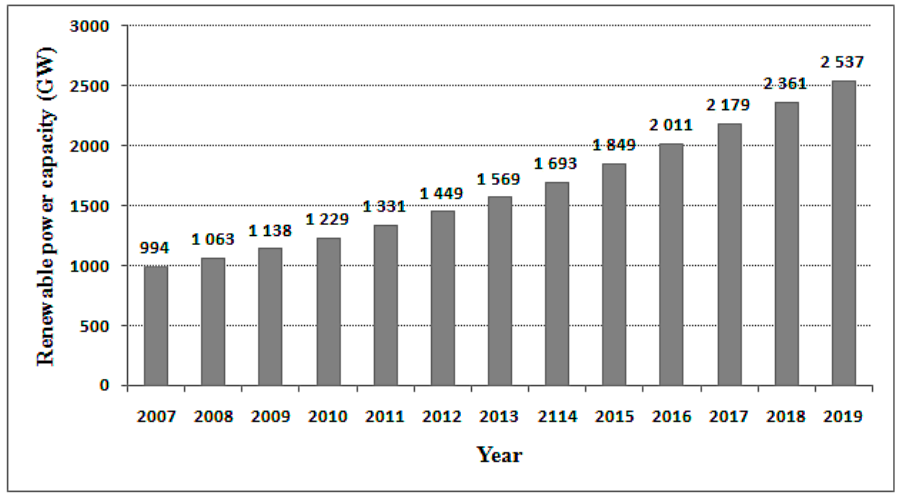
Figure 1. Global cumulative renewable power installed capacity growth (GW)